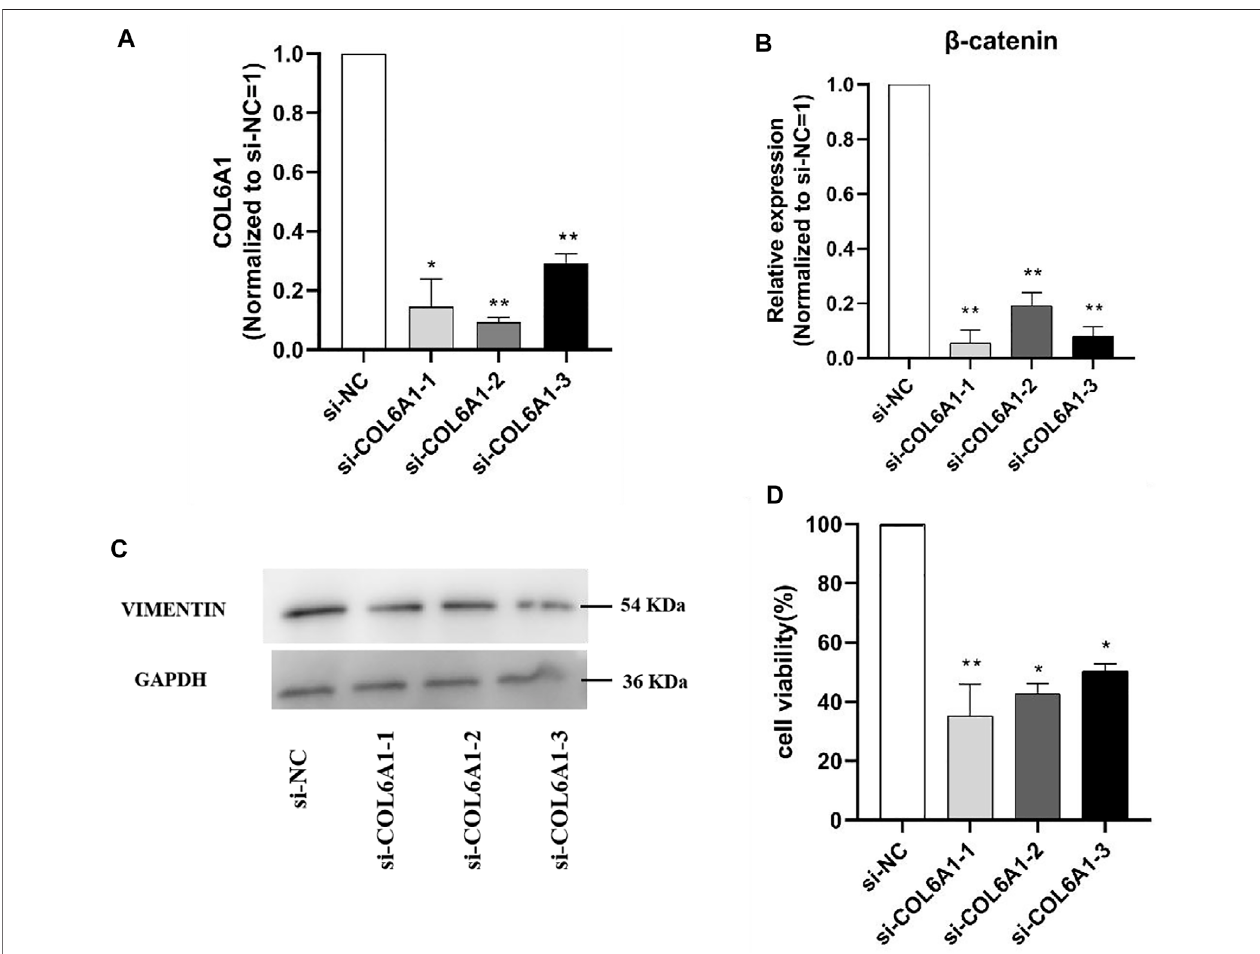
FIGURE11| EffectofinterferingCOL6A1onDPCsproliferation. (A) qPCRresultsofCOL6A1inDPCsat48 hwhenCOL6A1wasinhibitedusingsiRNA. (B) qPCR resultsofcellproliferationaftersiRNAtransfection. (C) WesternblotsofCOL6A1knockdownDPCsat48 h. (D) Cellproliferationwasassessedafter48